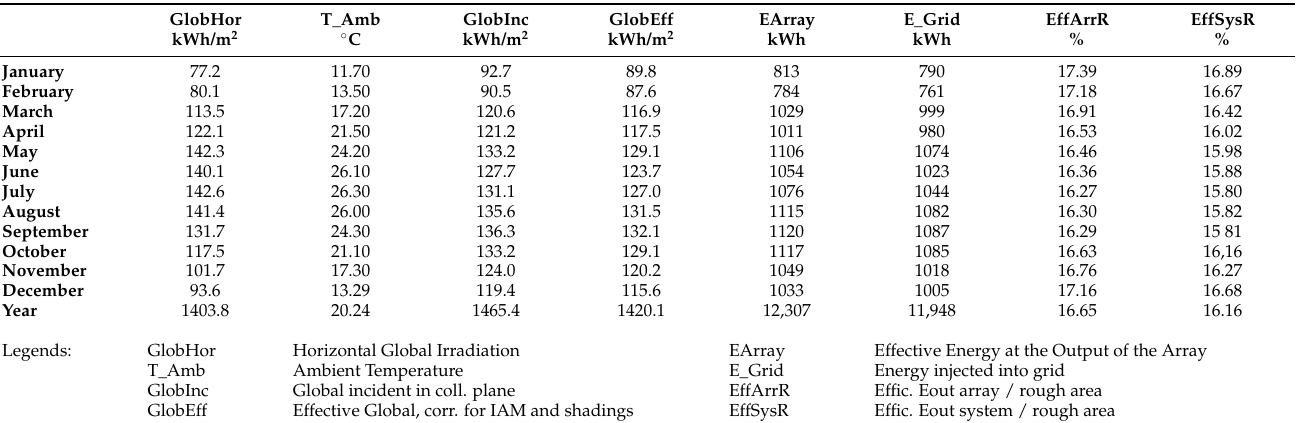
Figure 9. Monthly electricity of simulation results according to NASA data. Table 3. The simulation results according to NASA data.